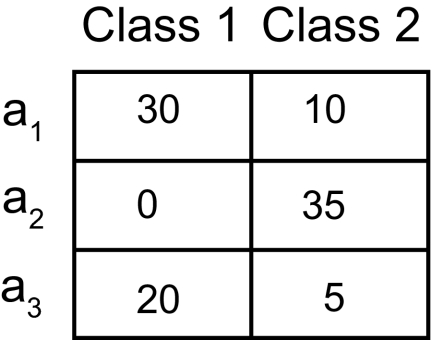
Joint distribution of attribute A and Class